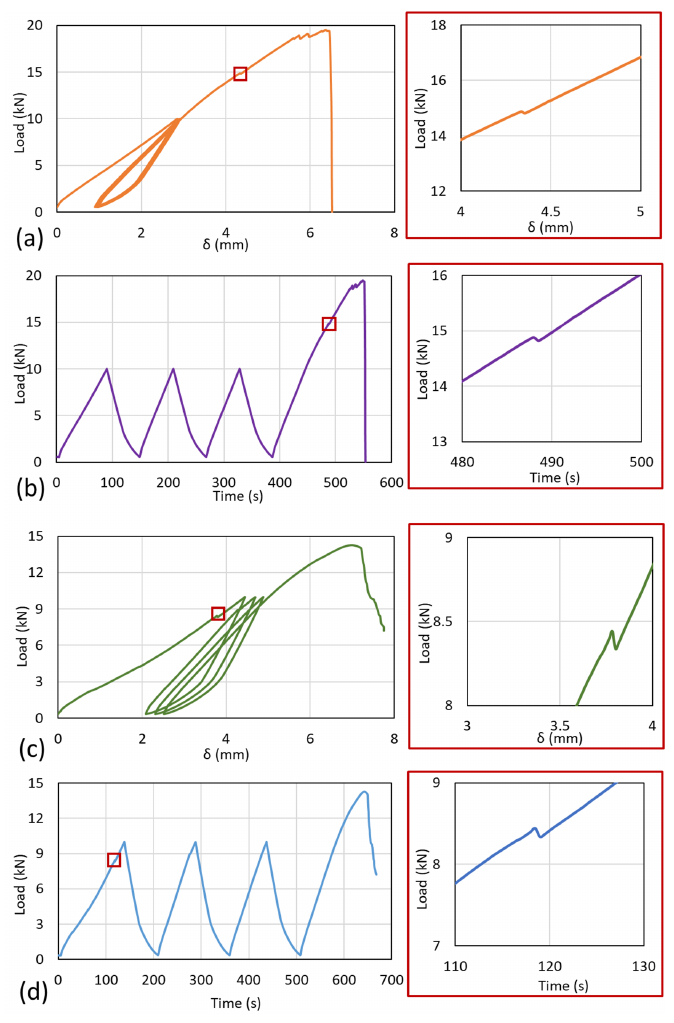
Figure 4. Stepwise loading from the different specimens. The [90/0] S sample with ( a ) load vs. displacement and ( b ) load–time. The [0/90] S sample with ( c ) load vs. displacement and ( d ) load–time.